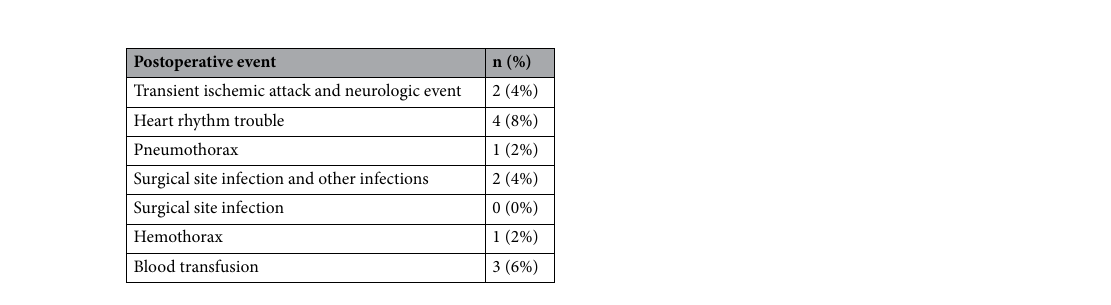
Table 3. Correlation between CT scan measurements and intervention times. Values in bold are those below the alpha risk threshold set at 0.05.